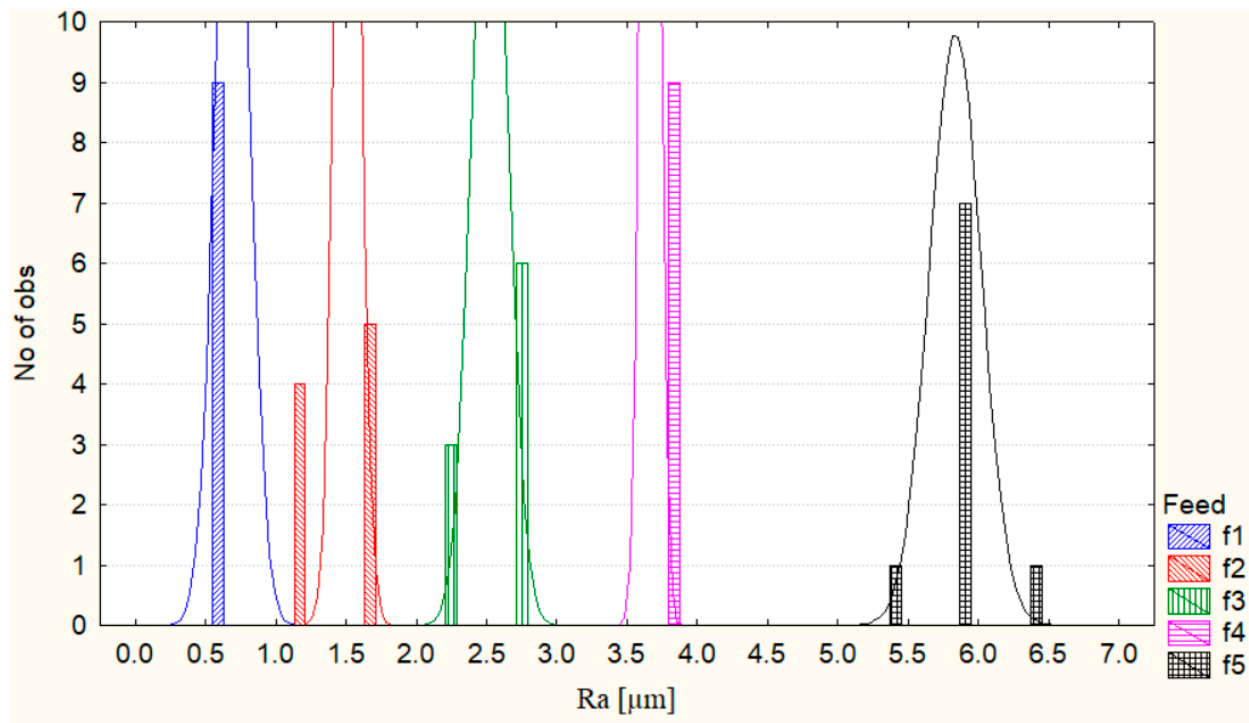
Figure 11. Histogram of the data measured after machining by turning. Next, using the scatter plot procedure, we compared the data in 5 rows in Figure